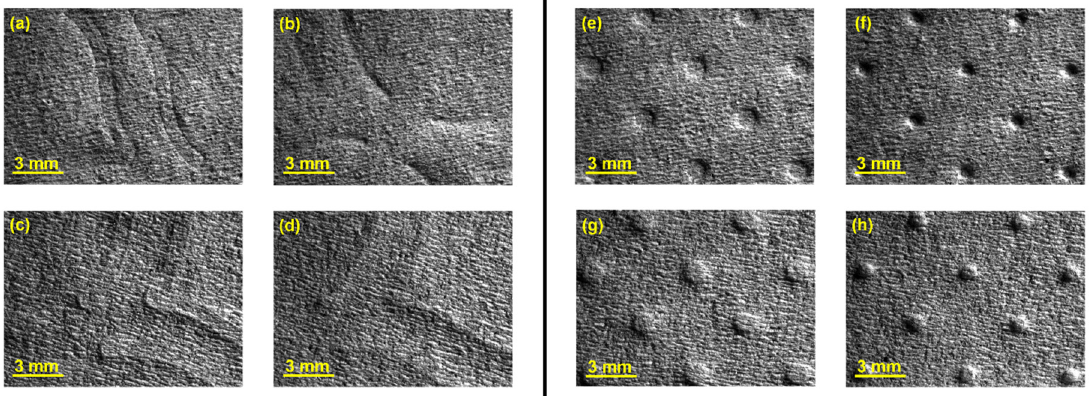
Figure 6. Global views of the tissue-paper samples engraved with the different considered embossing plates: ( a ) Bd sl (front side), ( b ) Bd rl (front side), ( c ) Bd sl (back side), ( d ) Bd rl (back side), ( e ) Bm sd (front side), ( f ) Bm rd (front side), ( g ) Bm sd (back side), and ( h ) Bm rd (back side).